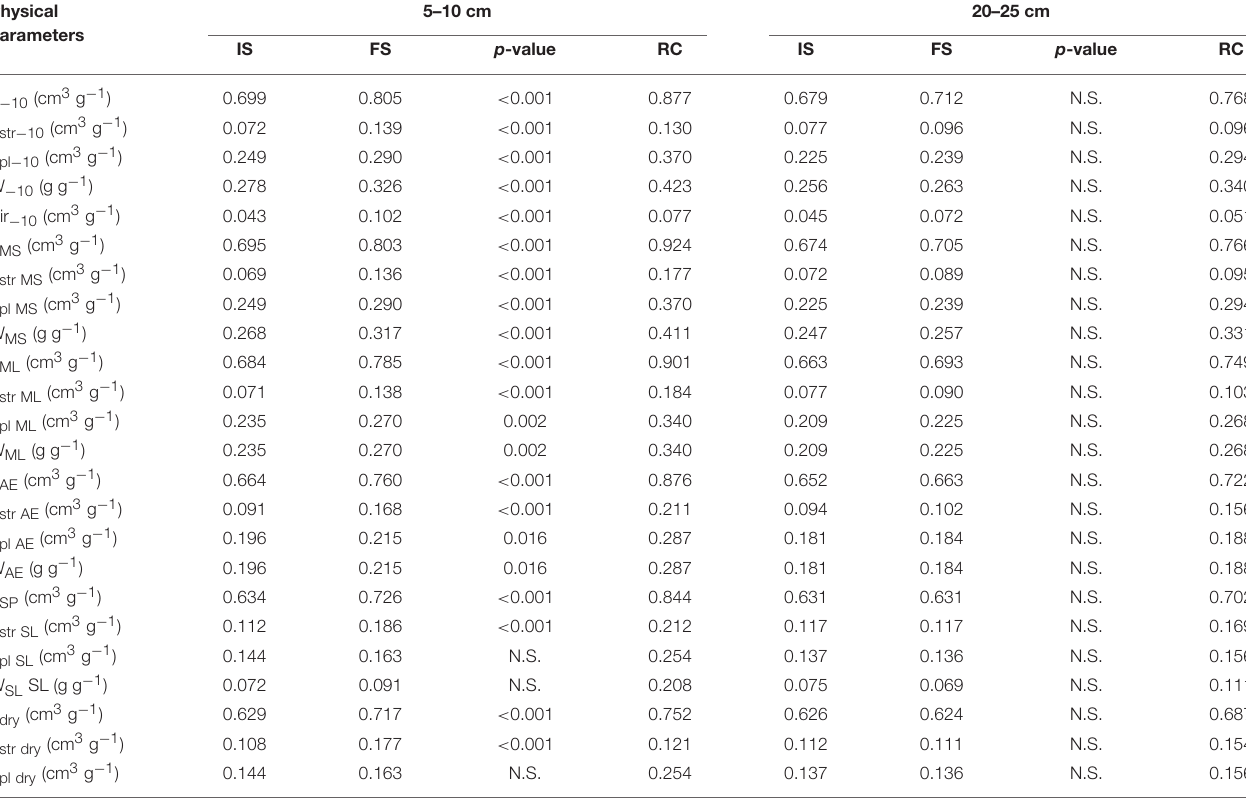
TABLE 2 | Average values of the parameters determined by shrinkage analysis before (IS) and after (FS) the experiment, and in the reference condition (RC) at the two sampling